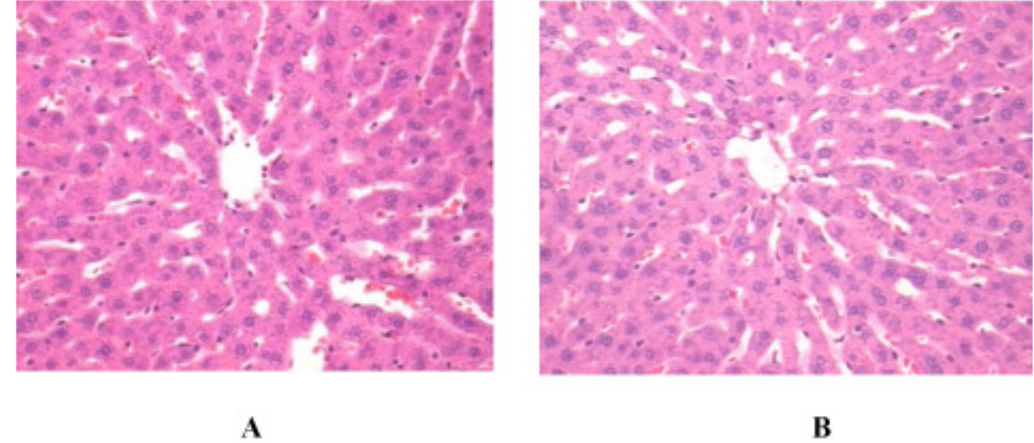
FIGURE 2 – A . Hepatic micrograph of control group. B. Hepatic micrograph of group treated with 50mg/Kg of Equisetum arvense L.